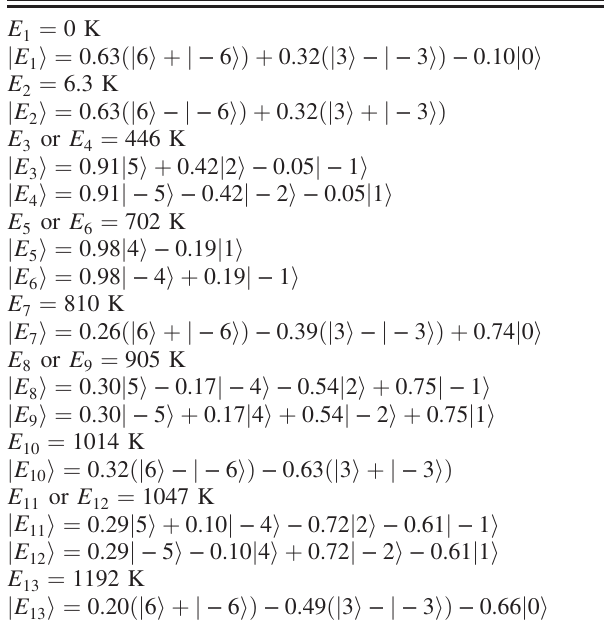
). The eigenvalues and eigen- ¼ J (cid:2) iJ x y (cid:2) and j E i ( j ¼ 1 – 13 ), j j